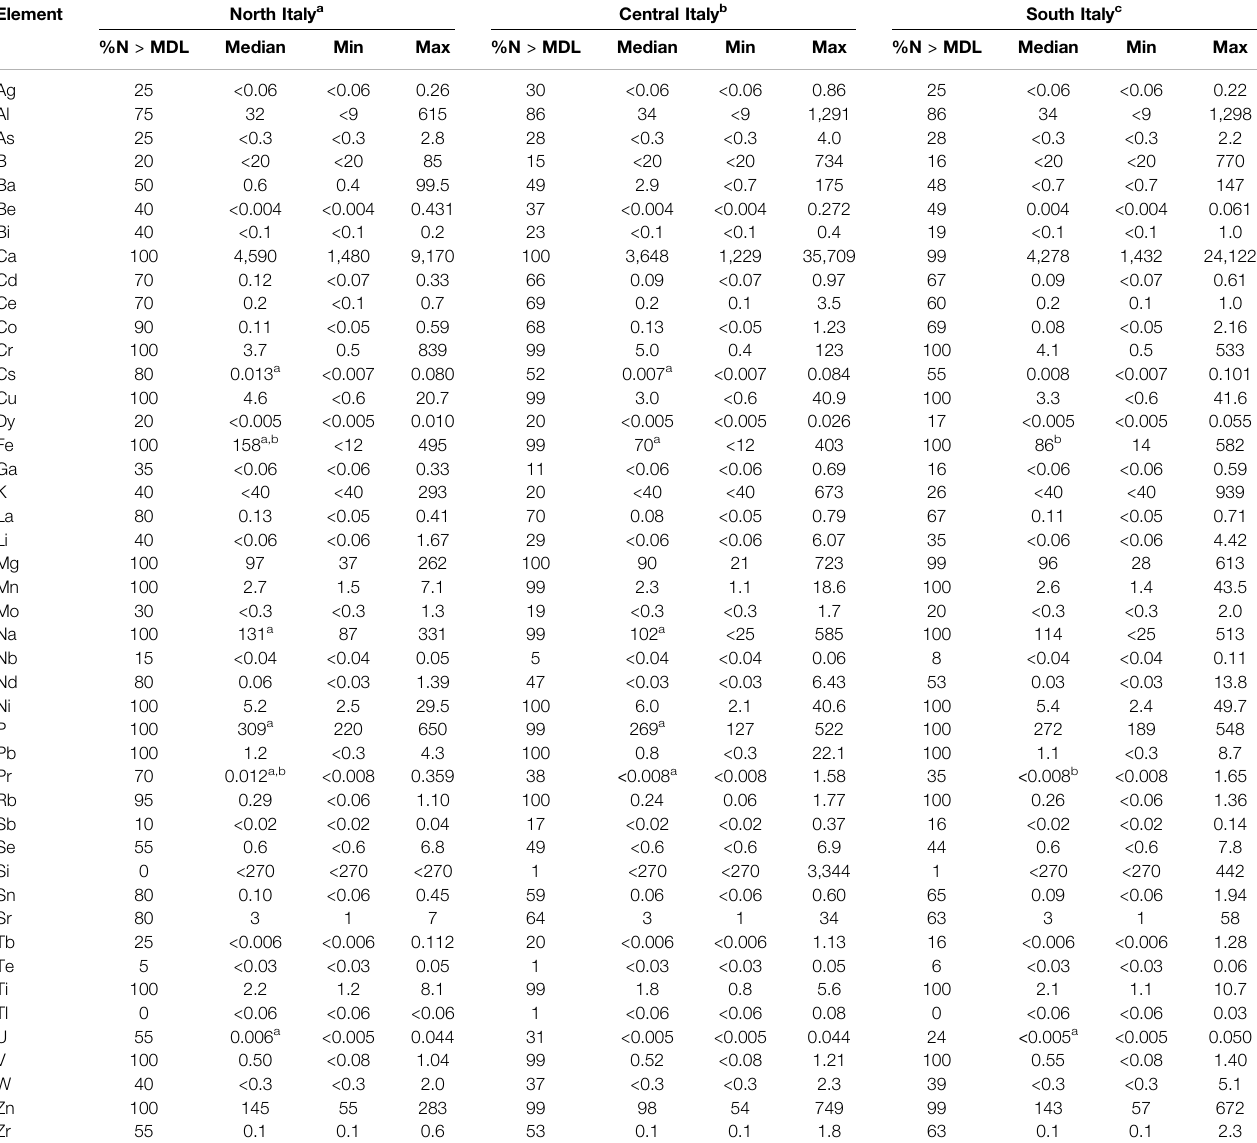
TABLE 3 | Element levels [median, minimum (min) and maximum (max); μ g kg − 1 ] in extra-virgin olive oils from north (n (cid:1) 20), central ( n (cid:1) 132) and south ( n (cid:1) 85) Italy.